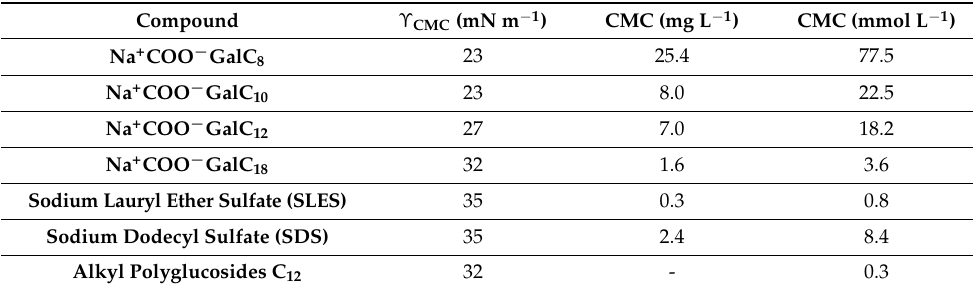
Table 4. CMC and surface tension at the CMC of CO 2 NaGalCn and reference surfactants. Standard deviation for the tensiometer is 0.01 N m − 1